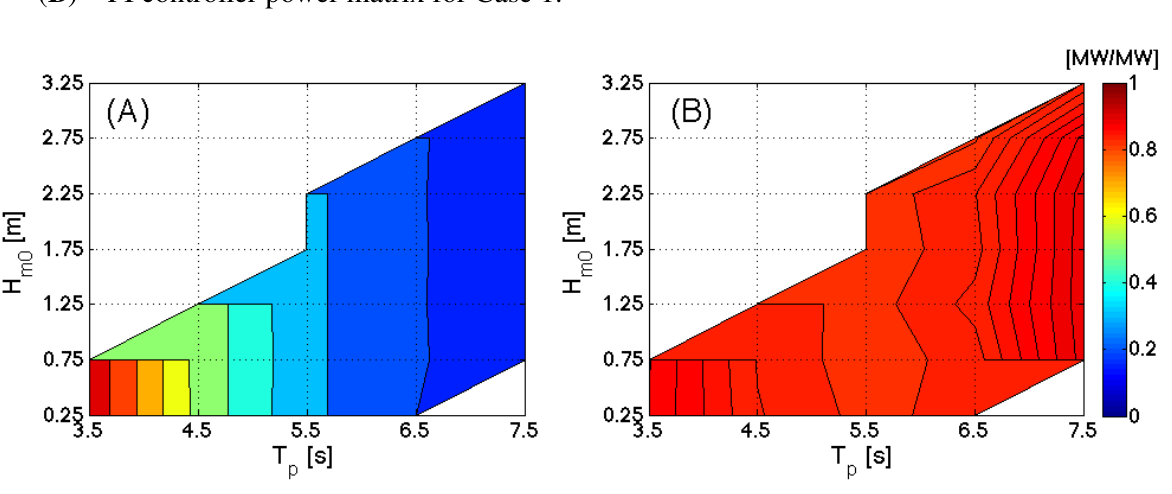
Figure 5. Comparison of P and PI controller power performance normalised by the MEC results, for unconstrained case (Case 1): ( A )—P controller power matrix for Case 1; and ( B )—PI controller power matrix for Case 1.